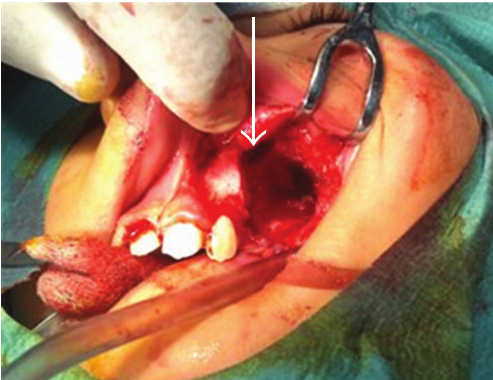
Figure 9: Cavity after enucleation arrow shows empty tooth socket in floor of the